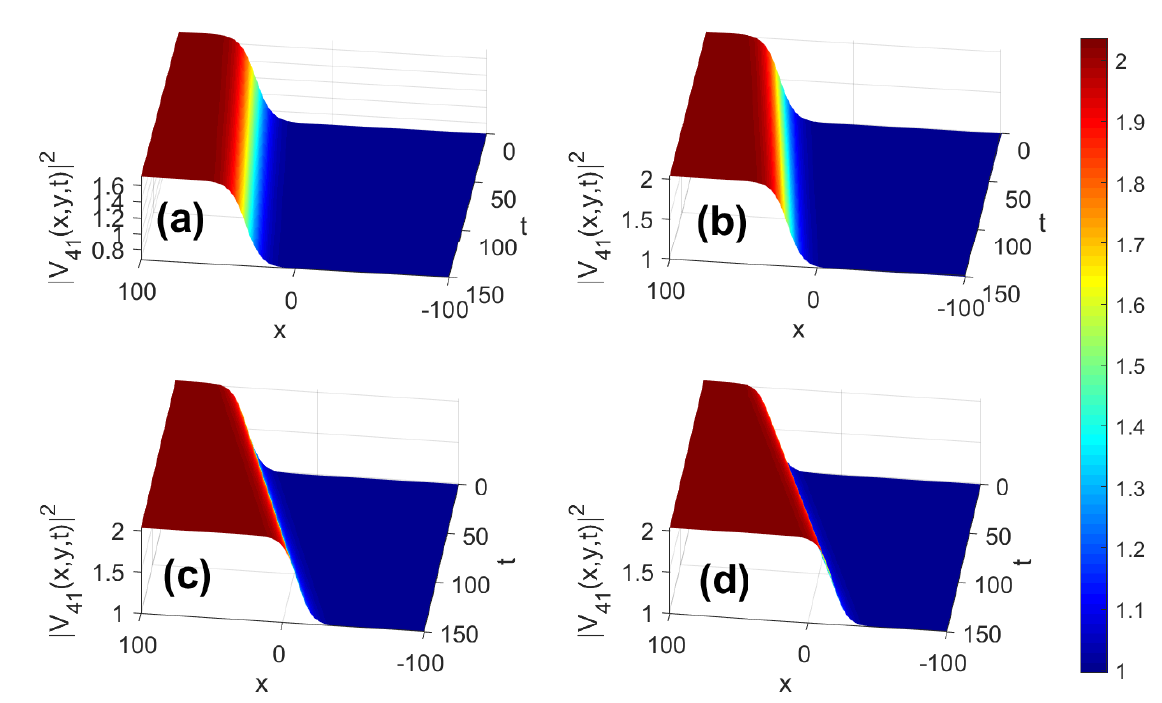
Figure 4. Spatio-temporal evolution of the Kink like-soliton with variation in the potential parameter β at different positions y . ( a – d ) are, respectively, the values of the parameter y ( a ) y = 0.1, ( b ) y = 0.3, ( c ) y = 0.4 and ( d ) y = 0.5. The parameters used are ϑ 0 = 0.2, β = 0.019 V − 1 , B 1 = 0.02, α = 0.22 V − 1